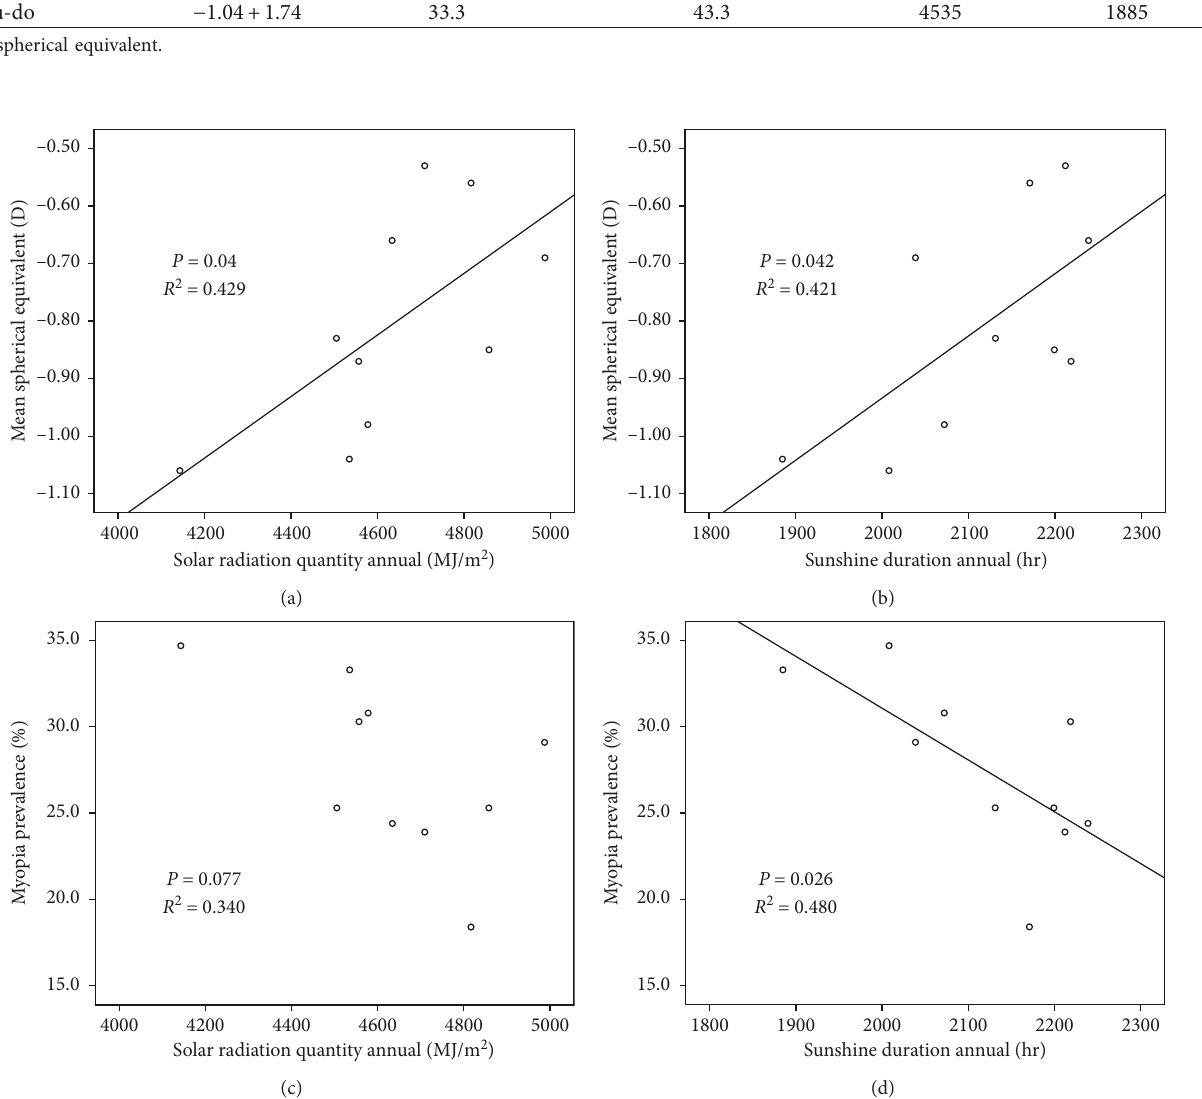
Figure 1: Scatter plot of solar radiation and sunshine duration with myopia degree and myopia